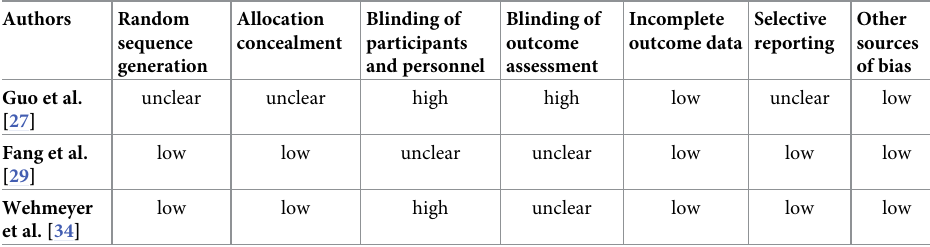
Table 4. Cochrane risk of bias tool’s table (RCT